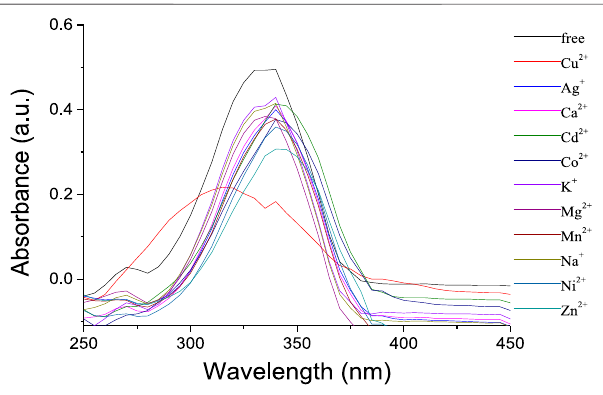
FIGURE 2 | UV-vis spectra of 1 (1 × 10 − 6 mol/L) upon addition of metal ions (10 equiv) in CH 2 Cl 2 /CH 3 CN (1,000:1, v/v).